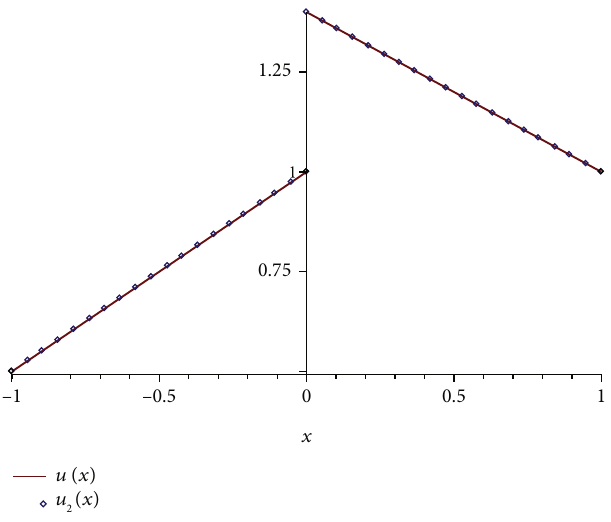
Figure 2: The graph of exact solution u ð x Þ and approximate solutions u